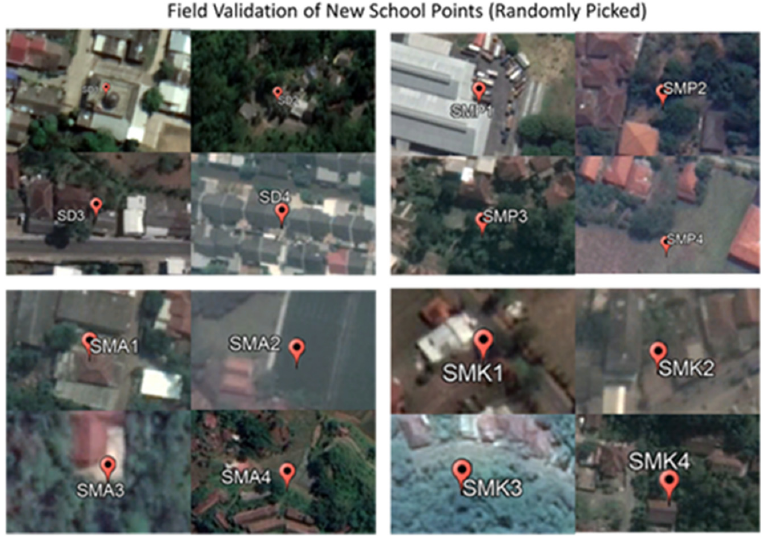
Figure 18. Field validation of the randomly picked new school points.